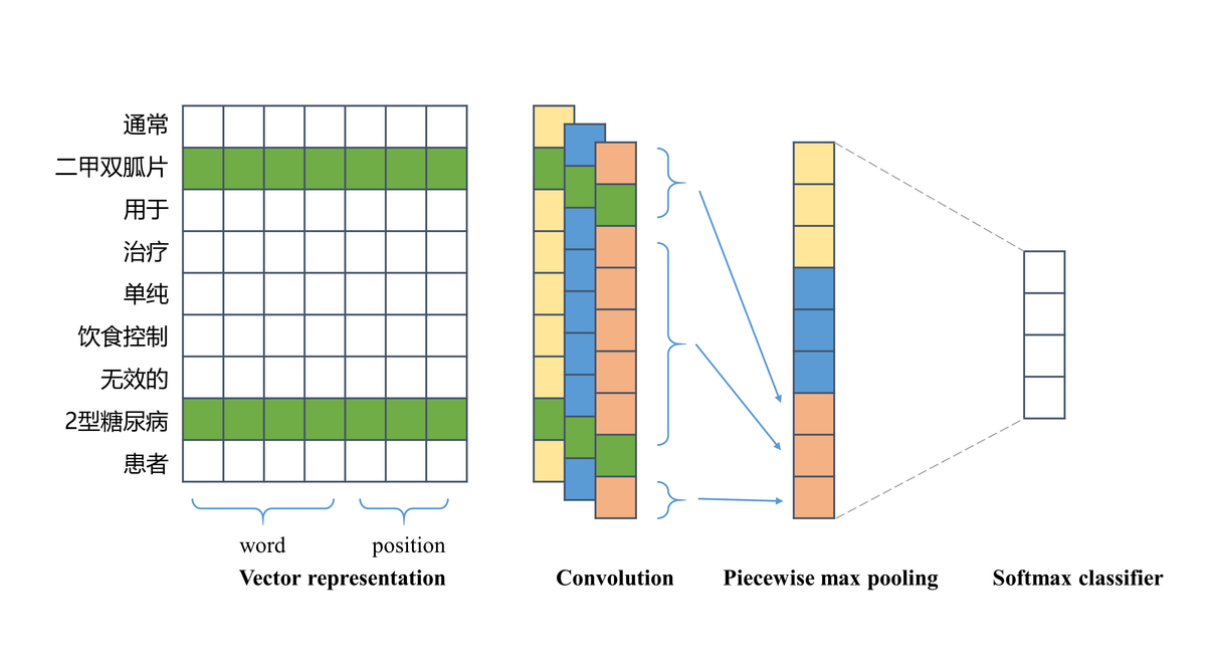
Figure 6. Piecewise convolutional neural networks